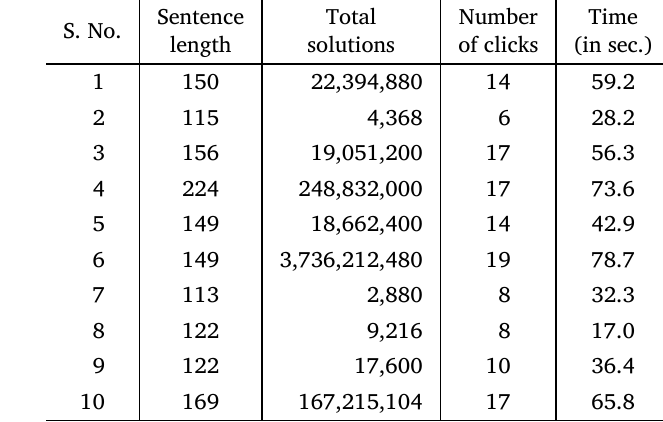
Empirical evaluation of the convergence time for 10 different